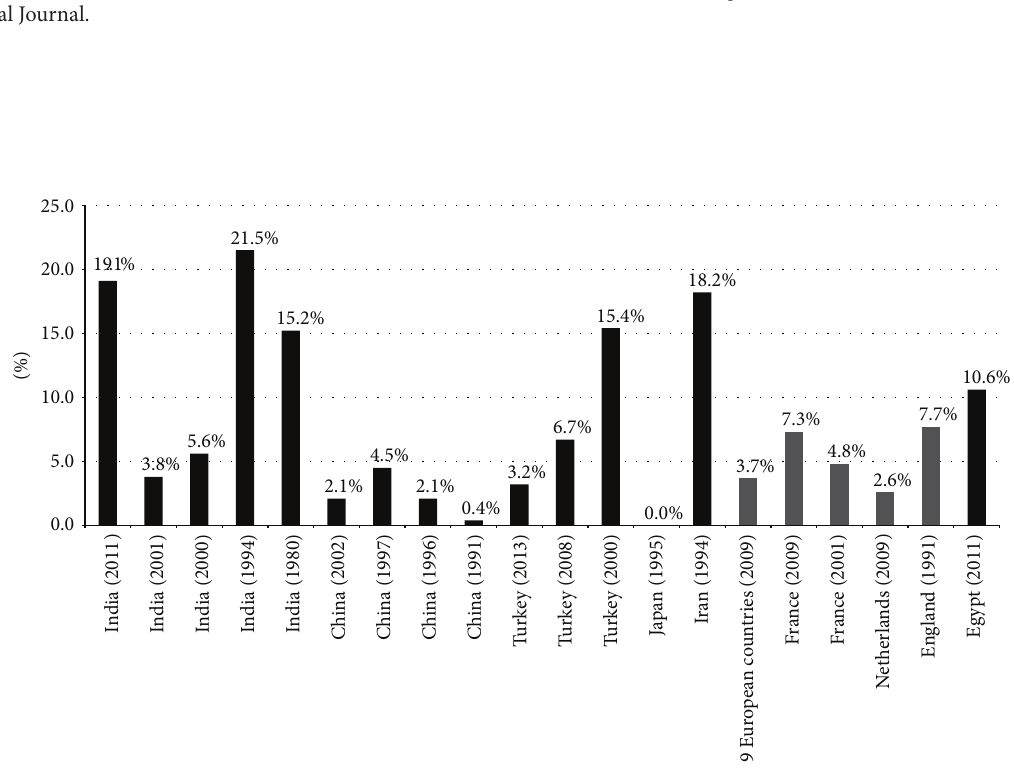
Figure 2: Prevalence of pregnancy-related BCS in different